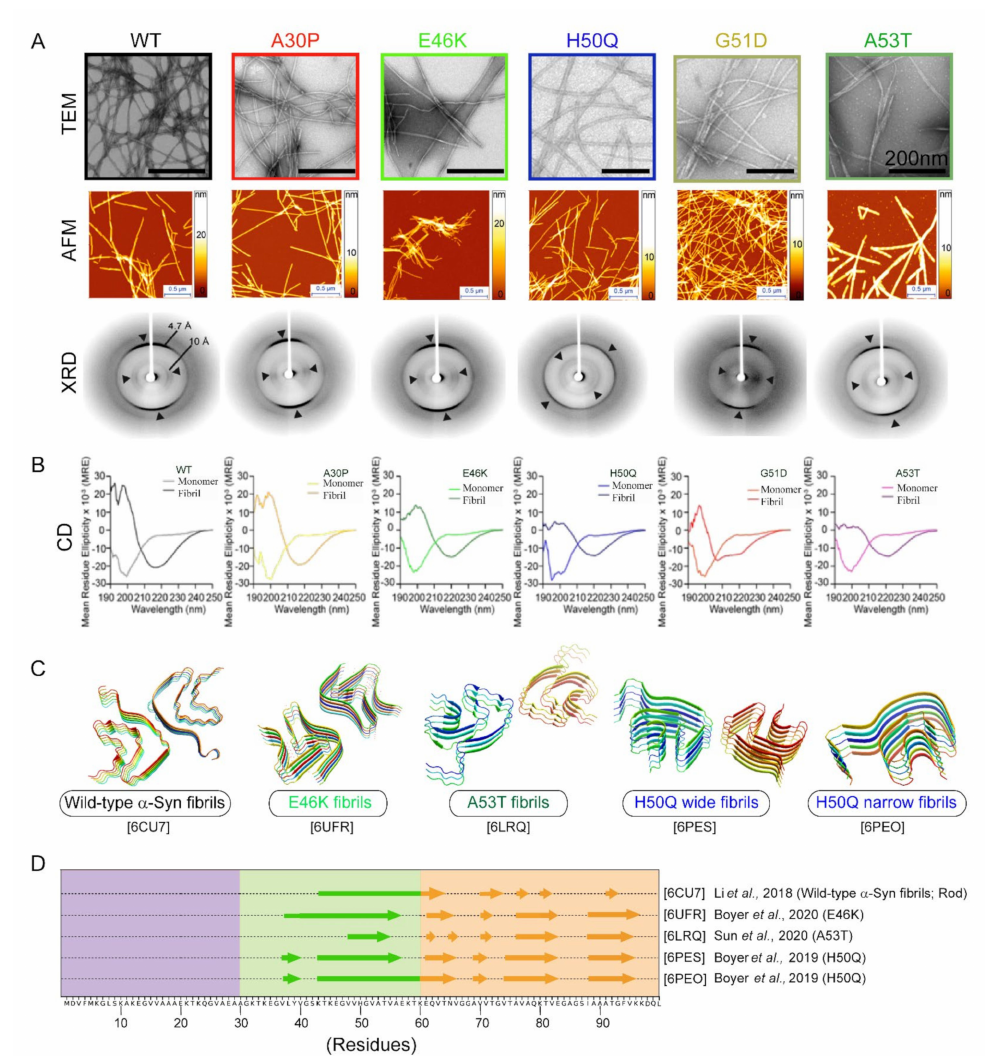
Figure 4. Polymorphism in WT α -Syn and its mutational variants. ( A ) Upper and middle panel . TEM and AFM images of WT α -Syn and its familial mutants (A30P, E46K, H50Q, G51D, and A53T) showing different fibril morphologies. Lower panel . X-ray diffraction pattern of fibrils formed by WT α -Syn and its point mutants showing a typical meridional reflection at 4.7 Å and variable equatorial reflection at ~8–10 Å among the wild type and mutants. ( B ) Secondary structure determination of WT α -Syn and its familial mutations by CD spectroscopy in its monomeric (light color) and fibrillar state (dark color). ( C ) cryo-EM models of WT α -Syn and its disease-associated mutants (E46K, A53T, and H50Q) fibrils. Corresponding PDB IDs of the structure are mentioned in the square bracket. ( D ) The schematic of 1–100 amino acids of α -Syn showing a comparison of β -sheet secondary structure in the WT and mutant fibrils. The α -Syn sequence is color-coded with residues 1–30, purple; 30– 60, green; 60–100 orange to distinguish between the position of β -sheet elements in the different structures. The TEM images for WT, A30P, and E46K are adapted with permission from D. Ghosh, P. K. Singh, S. Sahay, N. N. Jha, R. S. Jacob, S. Sen, A.